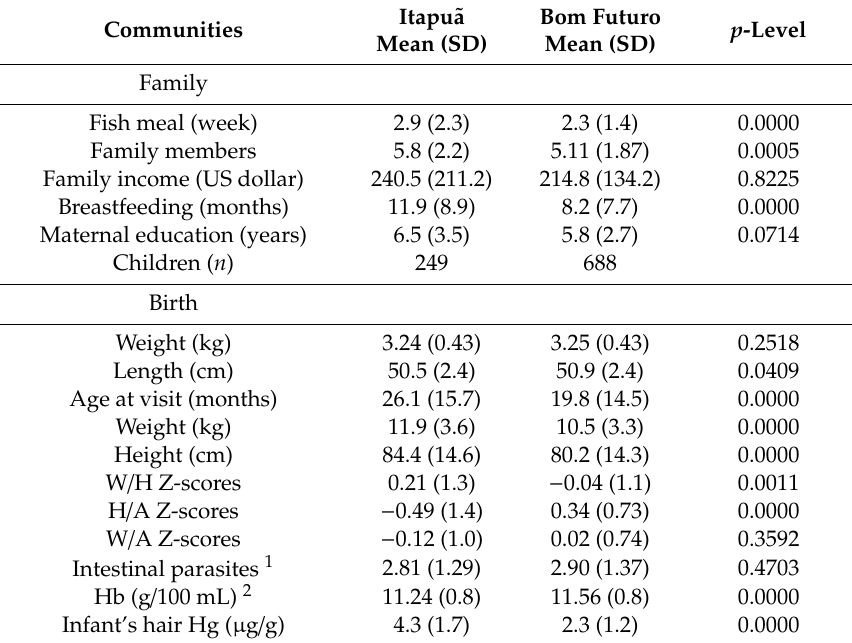
Table 1. General characteristics of families and children (937) comparing villagers of fishing community (Itapu ã ) with tin miners (Bom